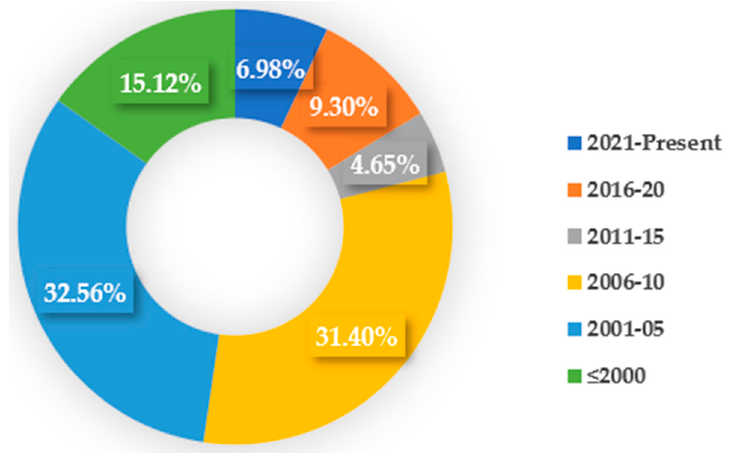
Figure 1. Number of papers considered in this study with publication